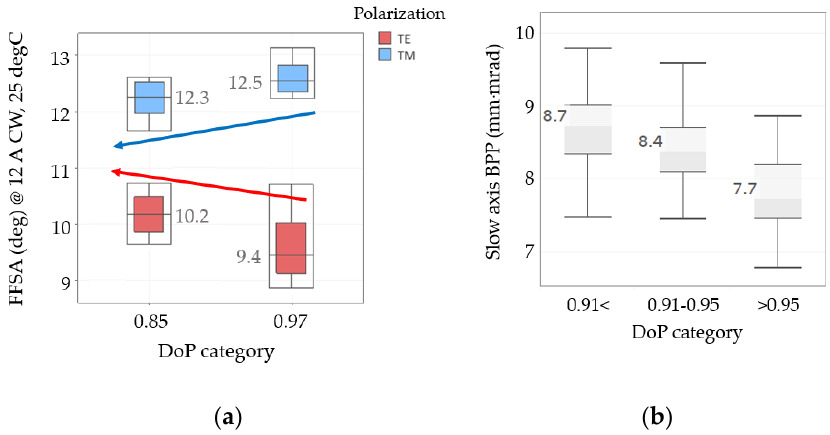
Figure 9. Measurements of HPLD with different DoP. ( a ) Polarization-resolved slow axis far-field changes for 8 HPLD with DoP = 0.85 and 11 HPLD with DoP = 0.97; ( b ) slow-axis BPP changes for HPLD divided into three DoP categories (93 with DoP < 0.91, 124 with 0.91 ≤ DoP ≤ 0.95, and 64 with DoP > 0.95).